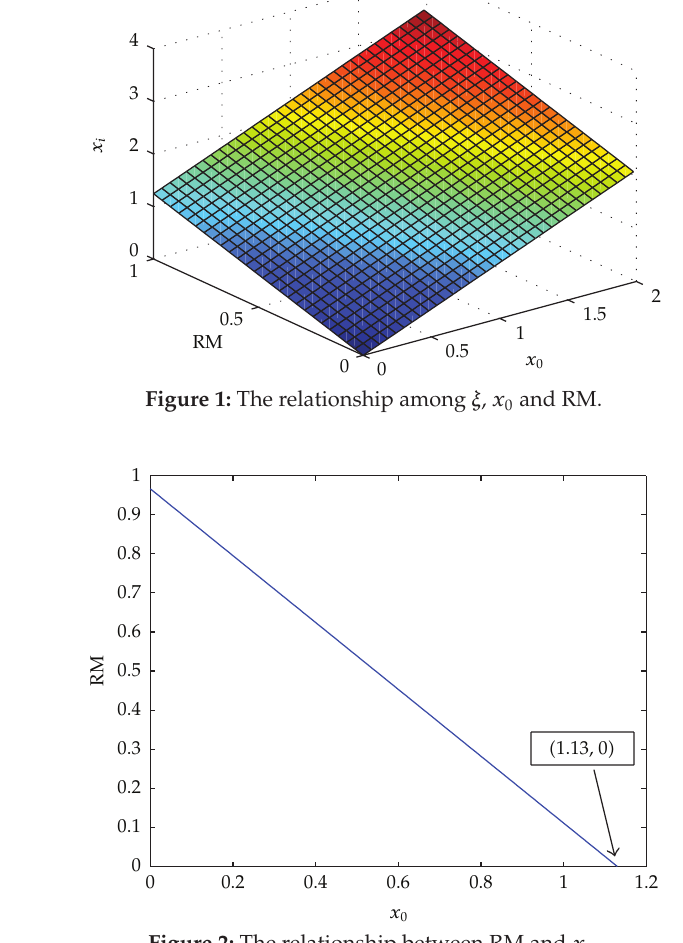
Figure 2: The relationship between RM and x 0